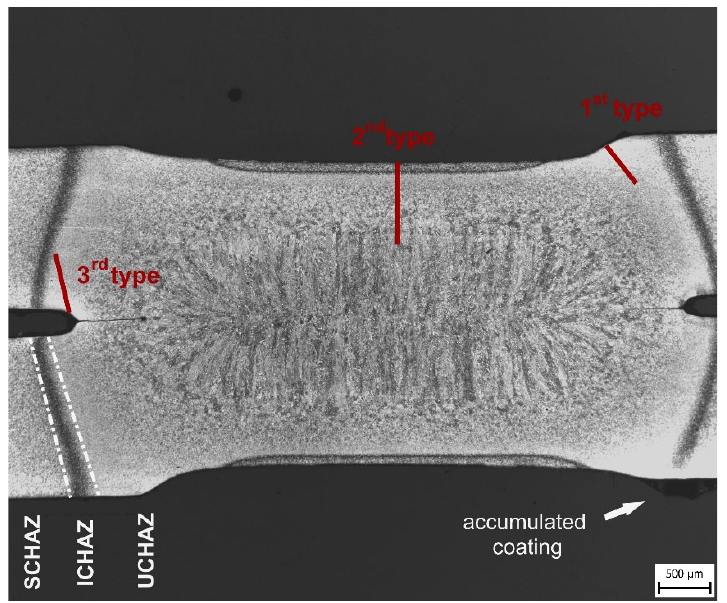
Figure 4. Typical macrostructure of the weld nugget of resistance spot welded martensitic steel with marked LME ‐ sensitive locations. The current used for welding was 6 kA.